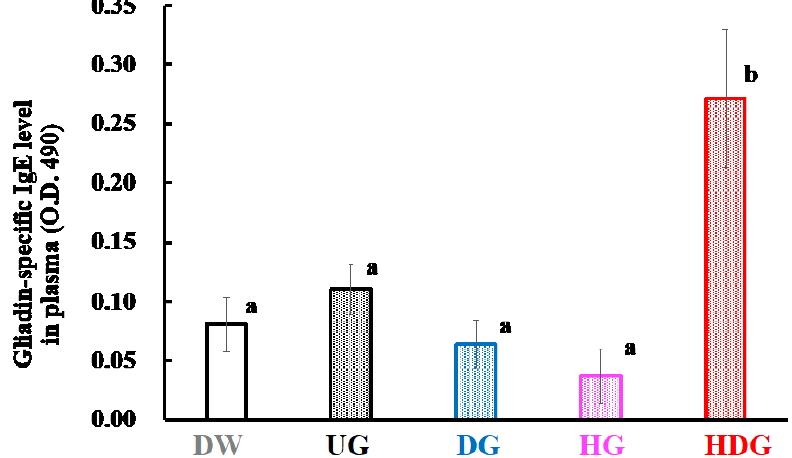
Figure 7. Gliadin-specific IgE levels in the plasma of mice after intraperitoneal challenge of gliadin followed by cutaneous sensitization with the corresponding gliadin. Values with different letters are significantly different at p < 0.05 based on the Tukey–Kramer test. Each value is the mean of eight experiments with SE shown as a vertical bar.